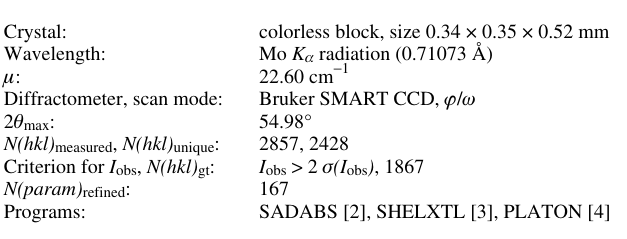
Table 1. Data collection and